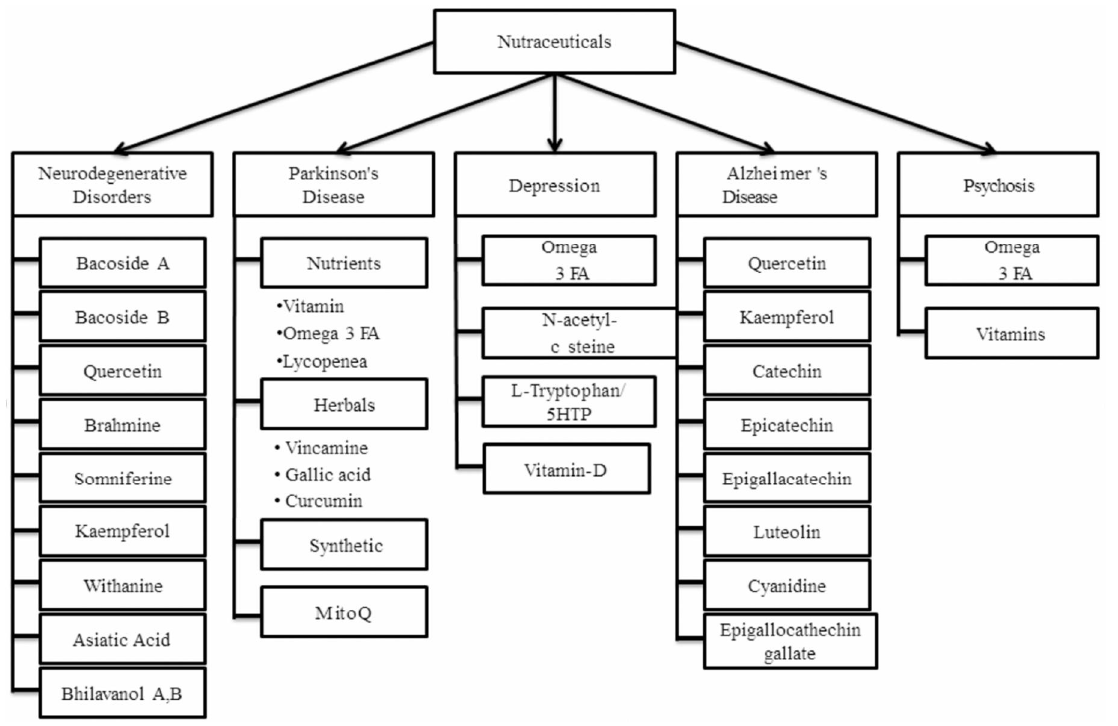
Figure 1. Some of the most commonly used nutraceuticals that can be employed as adjunctive therapy in the management of neurological degeneration, Parkinson’s disease, depression, Alzheimer’s disease, and psychosis simultaneously